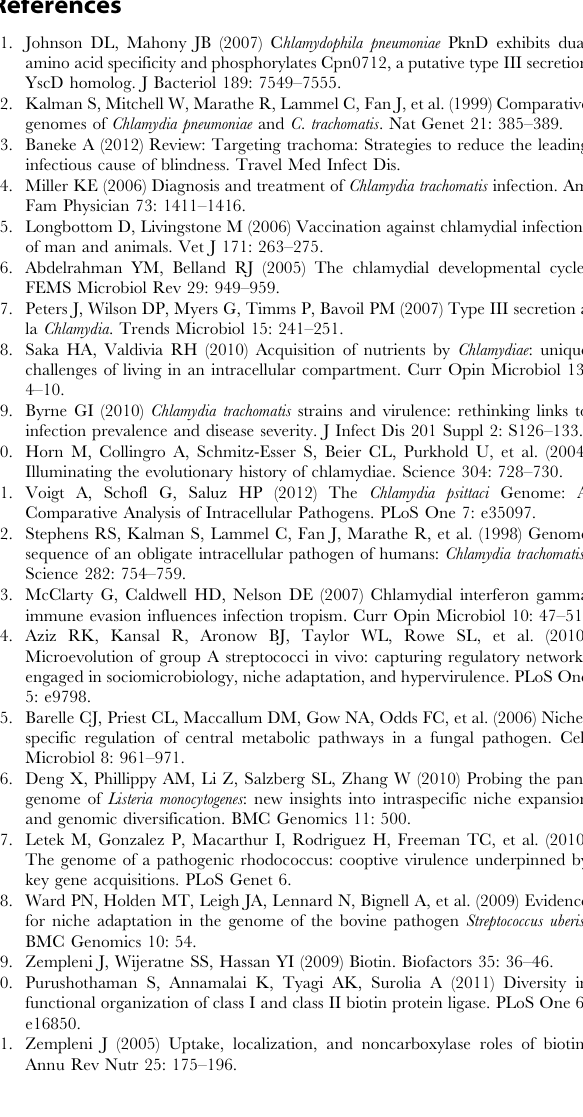
Table S2 K(m) and V(max) values for bacterial biotin transporters. (XLSX) Table S3 List of cell lines and bacterial strains used in this study.